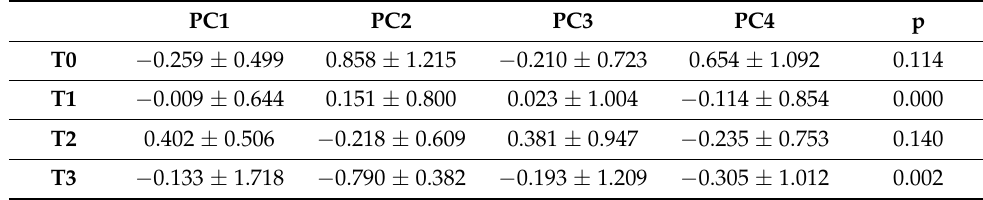
Figure 4. Two-dimensional PCA plot showing the discrimination of breathprints before smoking (blue circles) and 60 min after smoking (black stars). REGR = regression. Table 2. ANOVA of principal components at different time